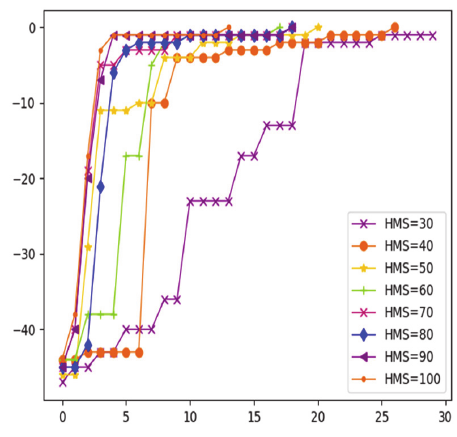
Fig. 17. Effect of HMS on performance of V3 Fig. 18. Effect of HMS on performance of V2